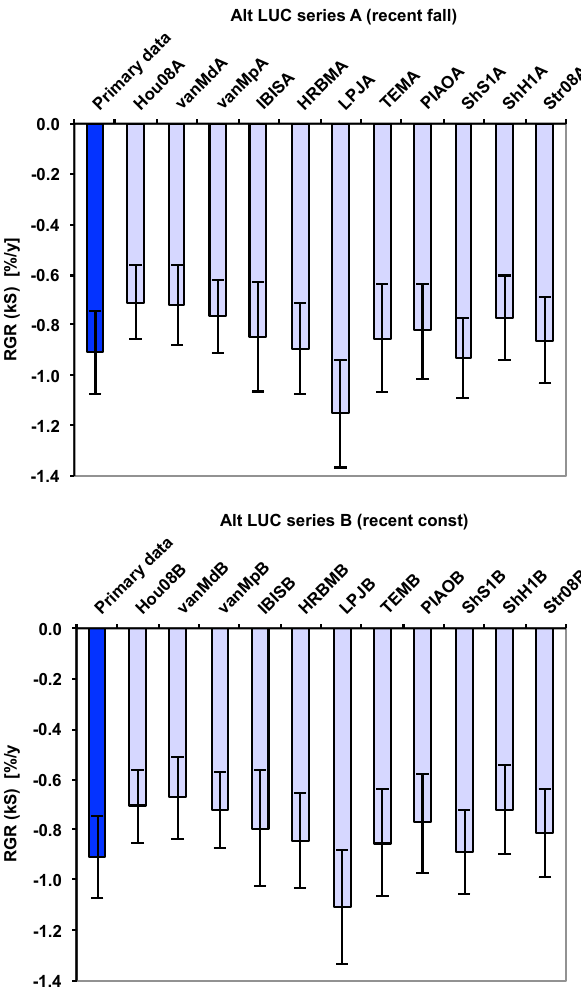
Figure D5. Estimates of RGR (k S ) using primary data for f LUC (blue bars) and 11 alternative f LUC trajectories (Table D1 and Fig. D3, pale grey bars). Trends are estimated using Eq. (A2). All Figure D5 (source: aaTrendEstimation.Results.V34.xls) P values (probability of negative k S trend) exceed 0.98 (values not tabulated). Other details follow Fig.